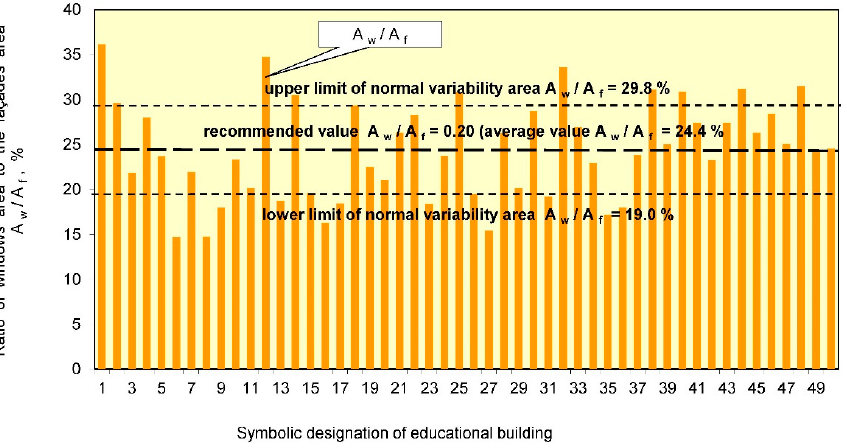
Figure 2. Values of the A w /A f indicator (ratio of windows area to the façades area) in education buildings.